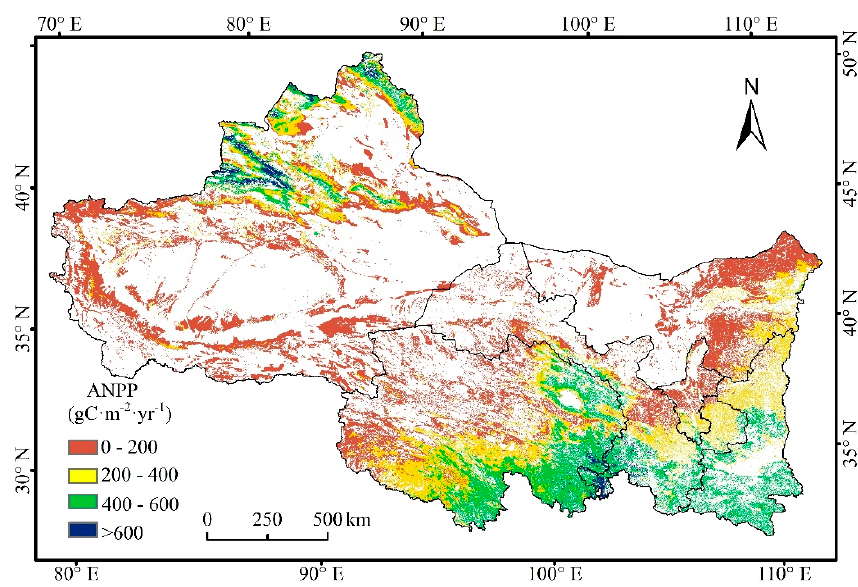
Figure 5. Spatial distribution of annual average ANPP.